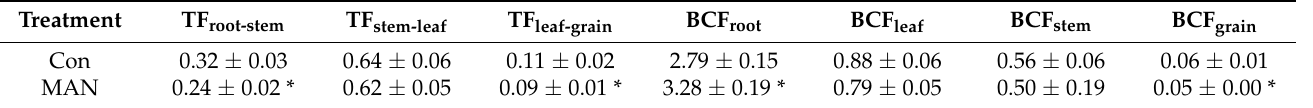
Table 5. Effects of MAN on the Cd transport and bioconcentration in potted soil